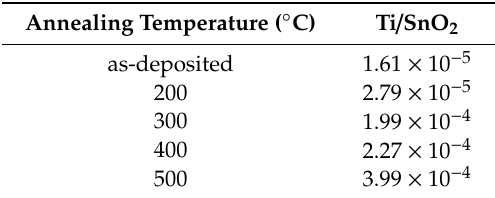
Table 4. The figure of merit of Ti / SnO 2 ( Φ TC ( Ω − 1